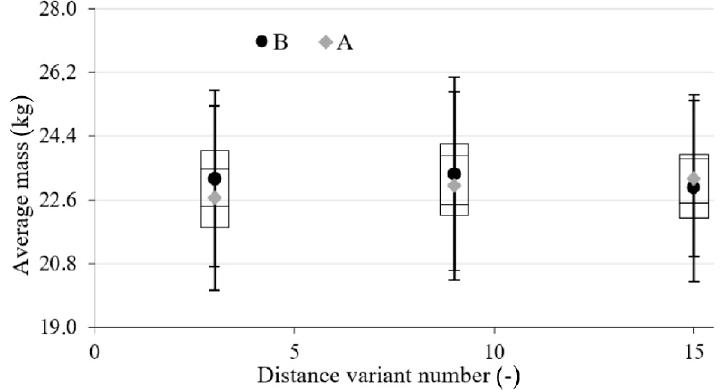
Figure 8. Average weight of full container, error bars are ± standard deviation, rectangles are ± standard error; A—for one operator, B—for two operators.